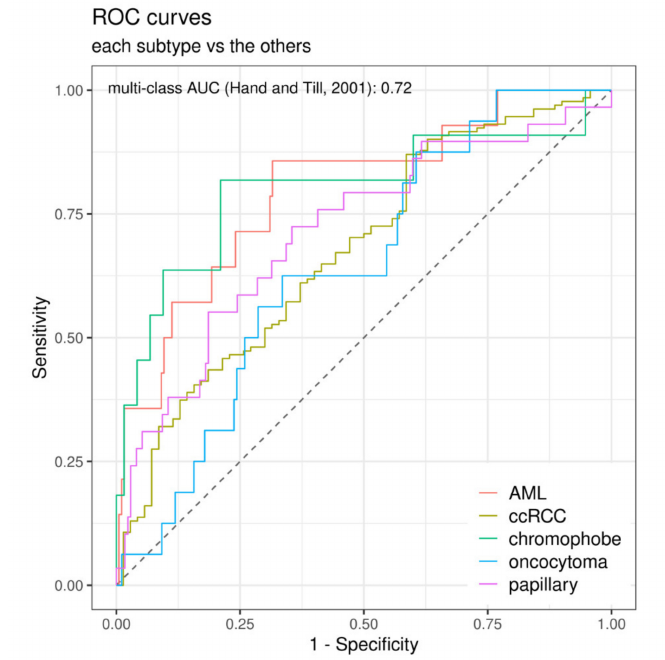
Figure 3. ROC curves for the extreme gradient boosting classifier (XG boost; with SMOTE and without feature selection). The displayed receiver-operating characteristics (ROC) curves show the discrimination of each subtype vs. the remaining ones as determined by the multi-class AUC described by Hand and Till [14]; AML: angiomyolipoma; ccRCC clear cell renal cell carcinoma; AUC: area under the ROC